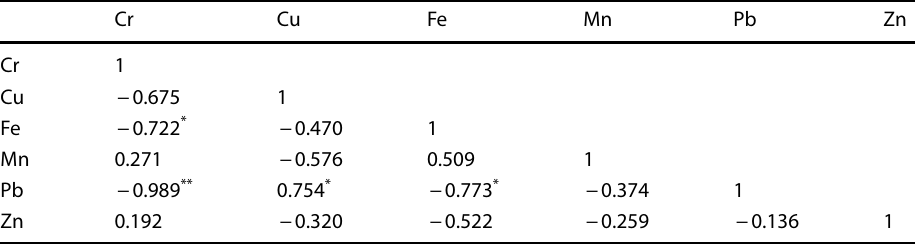
Table 9 Pearson’s correlation analysis between the metals in water samples from the 4 locations